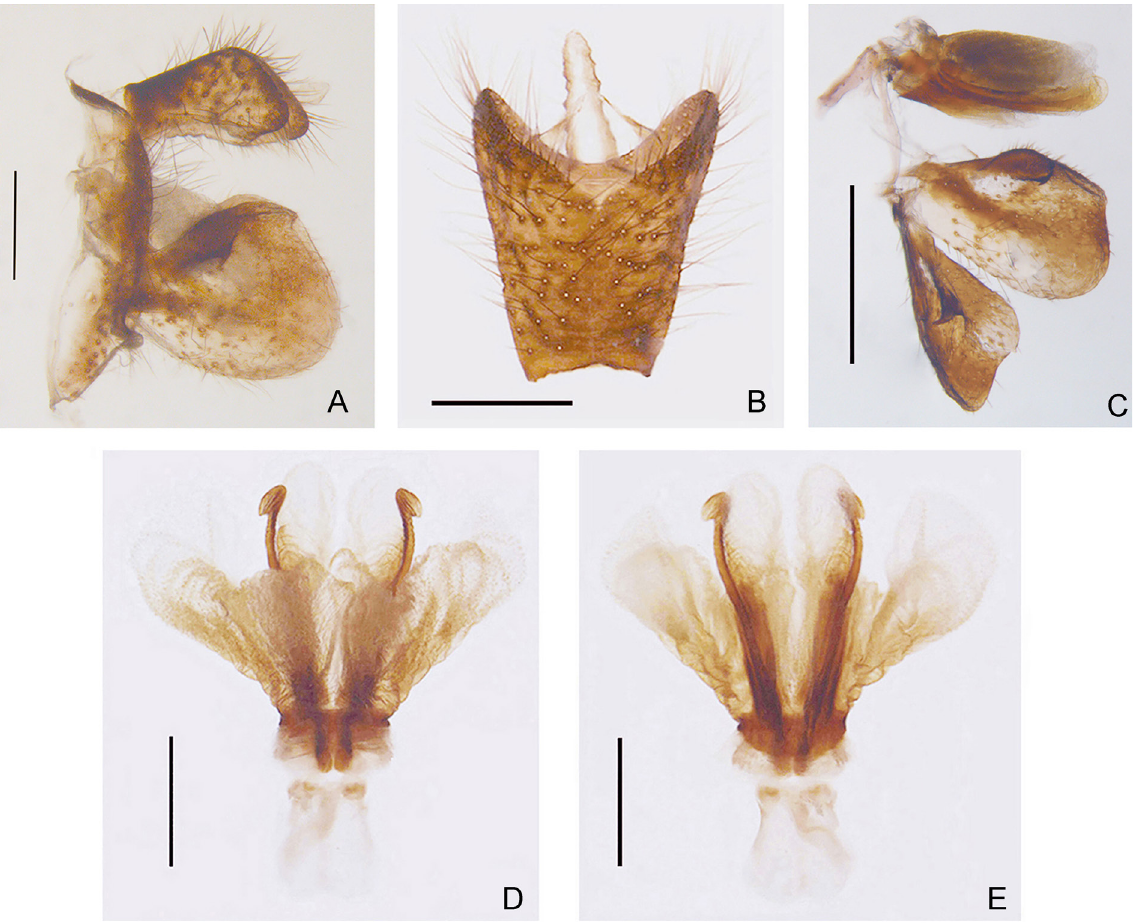
Fig. 7. Limois sordida sp. nov., Shanxi, Ningwu, Mt. Luyashan, Ai-ping Dong leg., NWAFU, male genitalia. A . Left lateral view. B . Anal tube, dorsal view. C . Aedeagus and gonostylus. D . Aedeagus, dorsal view. E . Aedeagus, ventral view. Scale bars = 0.5